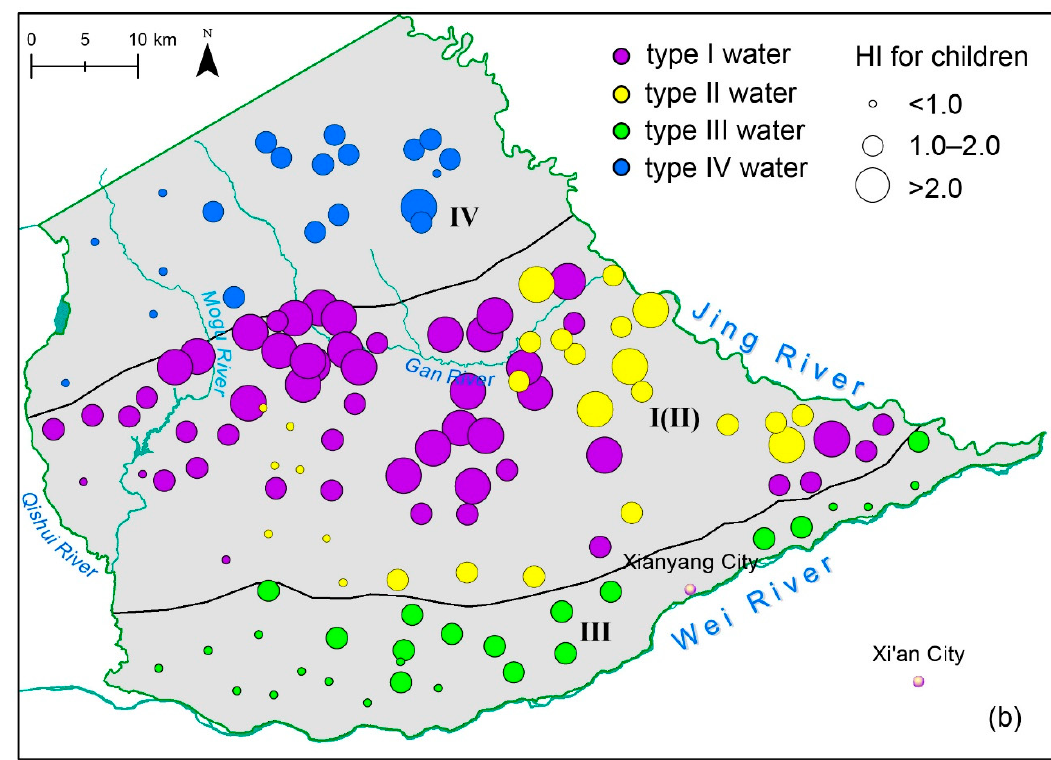
Figure 10. Hazard index ( HI ) of fluoride spatial distributions for ( a ) adults and ( b ) children.